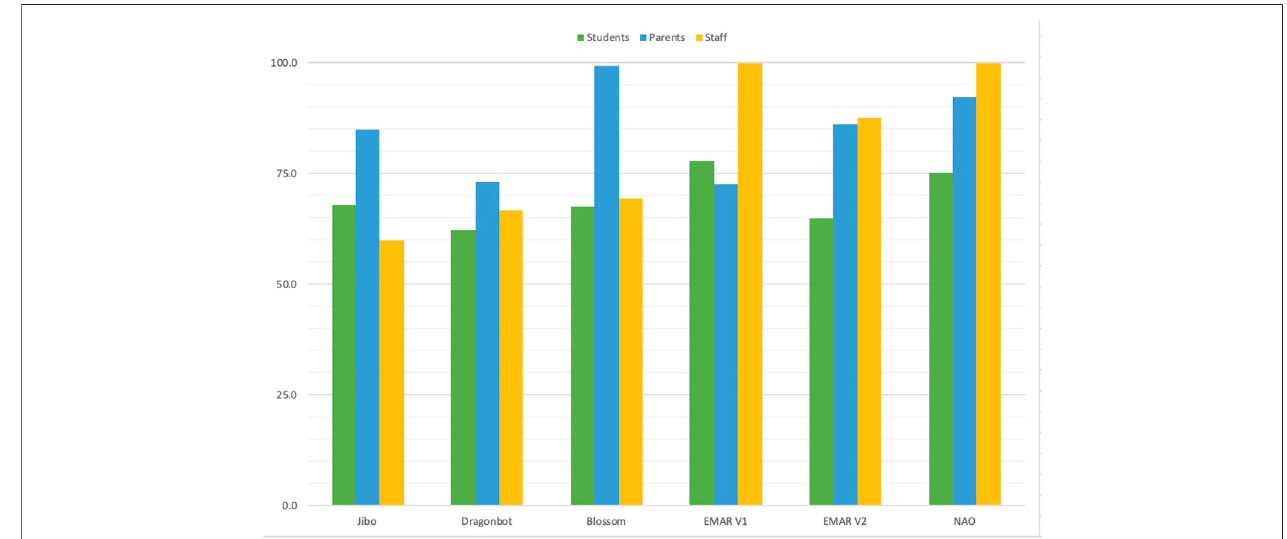
FIGURE 5 | Illustration of parent, staff, and student positive attribute percentages for each